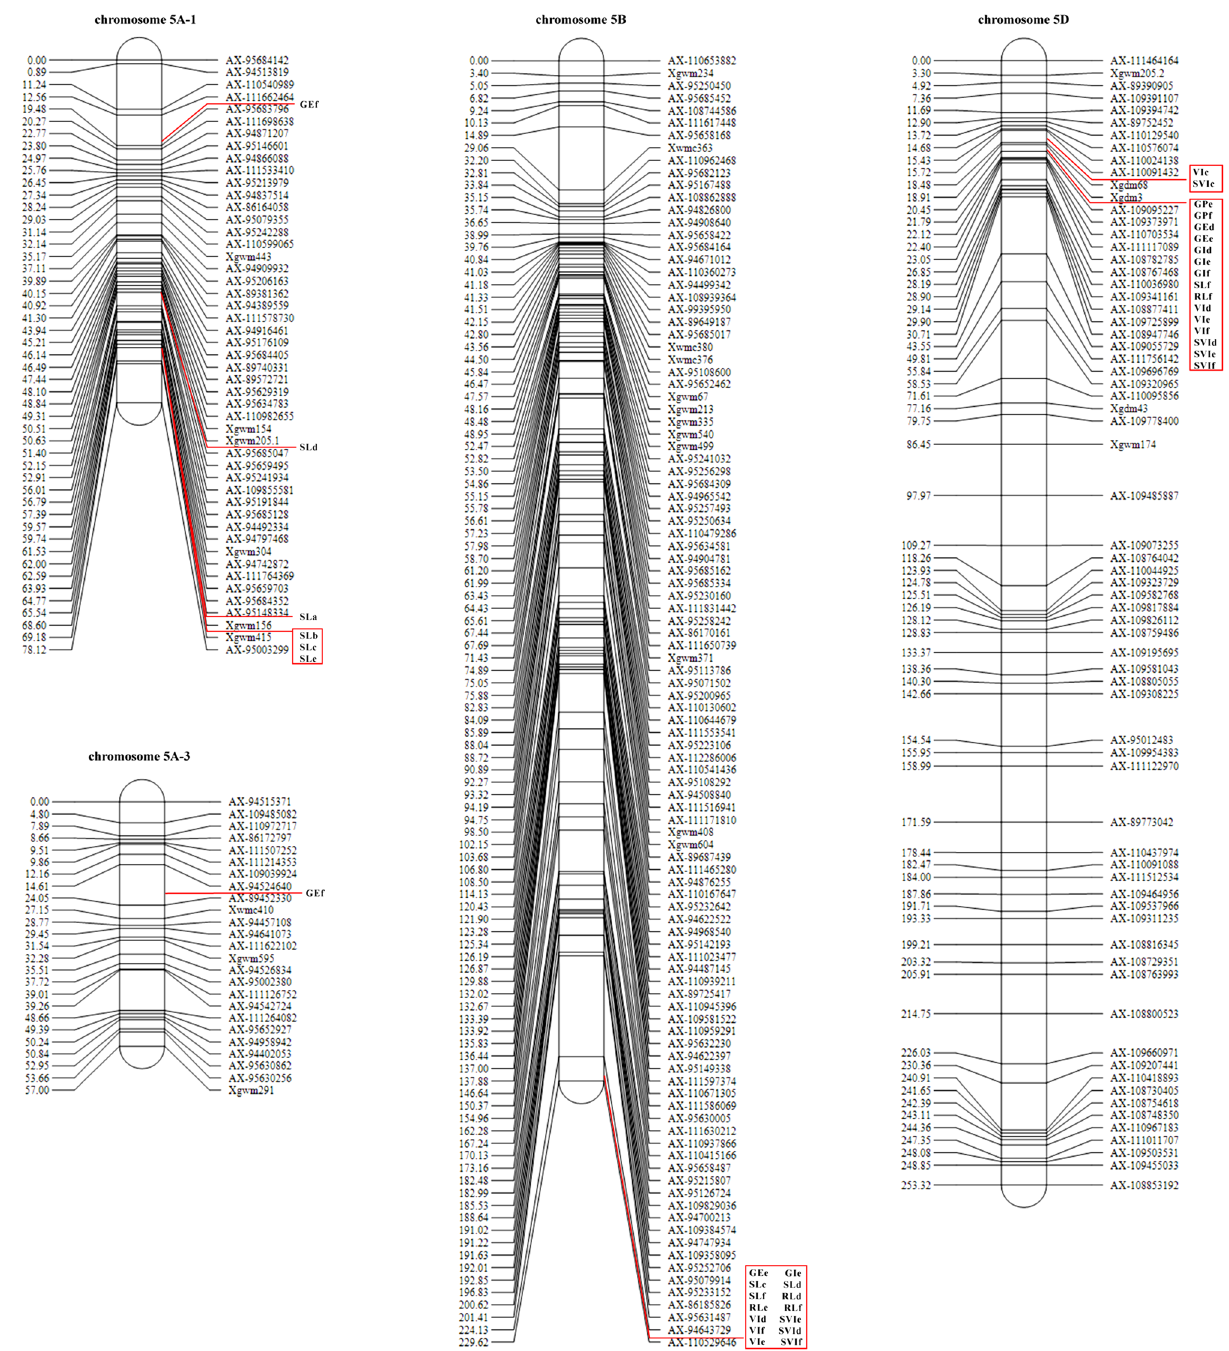
Figure 4. Distribution of additive QTL hotspot regions in seed vigor traits of wheat DH